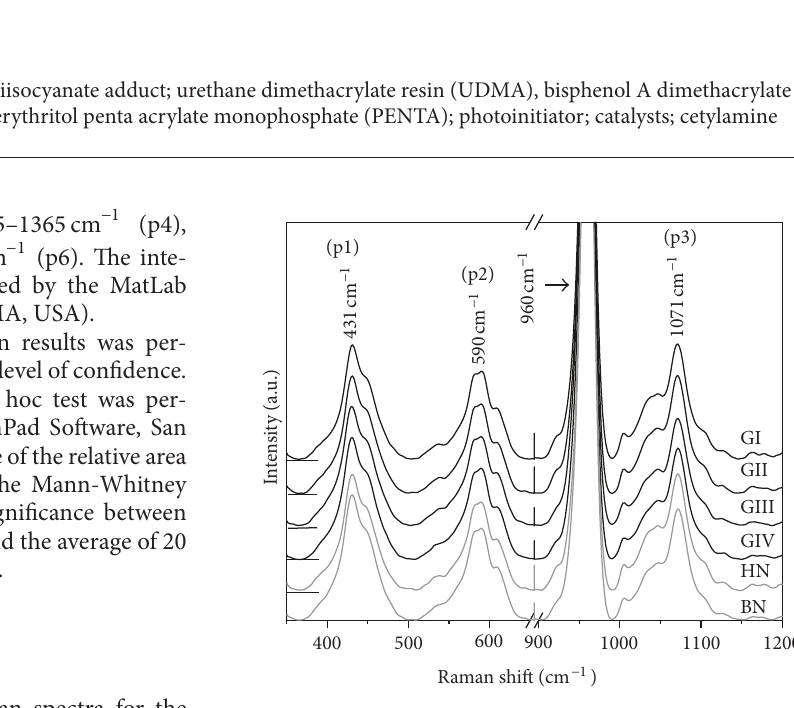
F1:ComparisonofFT-Ramanspectraofmineralcomponents from normal bovine dentin (BN) and normal human dentin (HN); human dentin treated with Xeno III (GI) and Prime & Bond 2.1 (GII) adhesives; bovine dentin treated with Xeno III (GIII) and Prime & Bond 2.1 adhesives